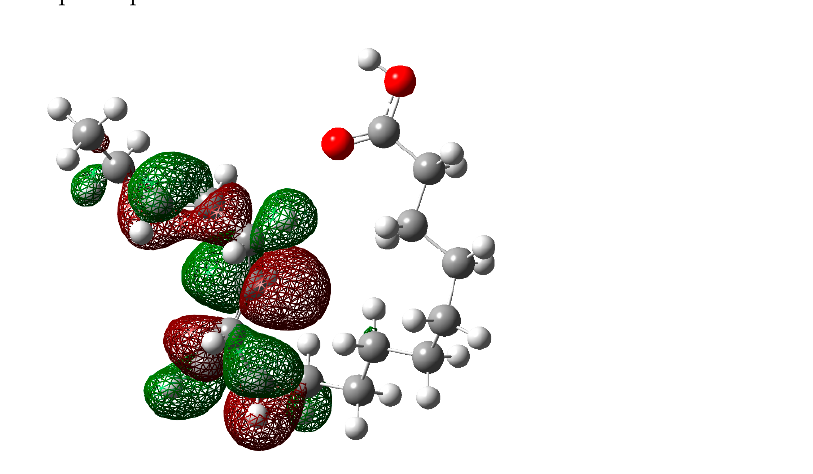
Figure 14. The lowest unoccupied molecular orbital (LUMO) for the protonated α -linoleic acid in the aqueous phase.